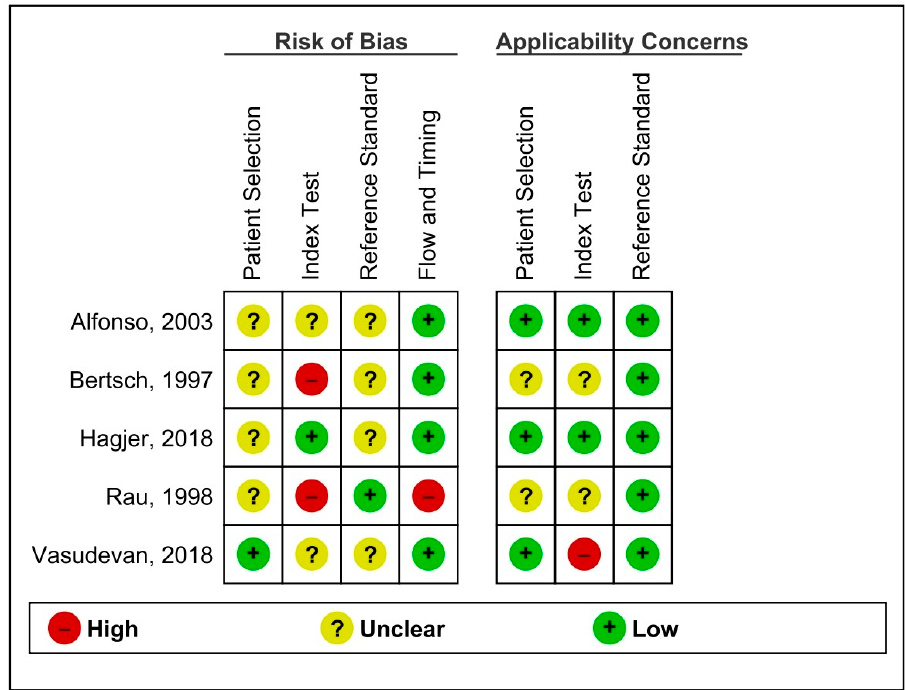
Figure 5. Risk of bias and applicability concerns graph.